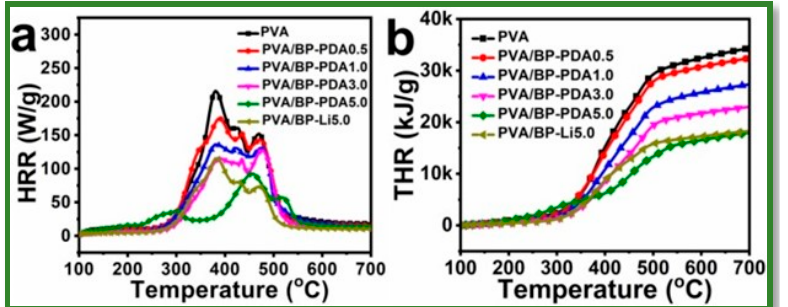
Figure 8. Combustion calorimeter (MCC) results of pure PVA and its nanocomposites: ( a ) heat release rate (HRR) and ( b ) total heat release (THR) versus temperature curves. Copyright 2020, Elsevier Inc.